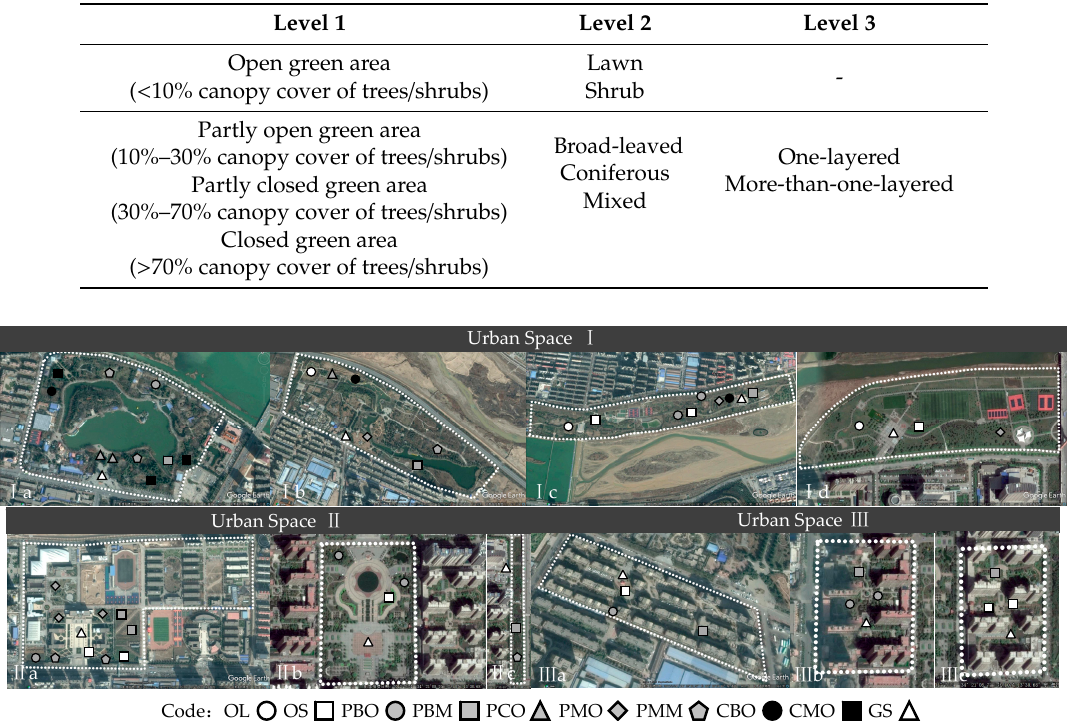
Table 1. Classification of Baoji City green area with vegetation structure factors.